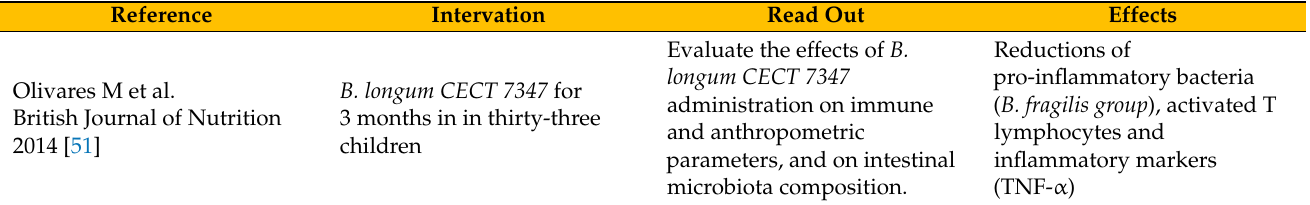
Table 5. Effect of probiotics in vivo studying on GFD